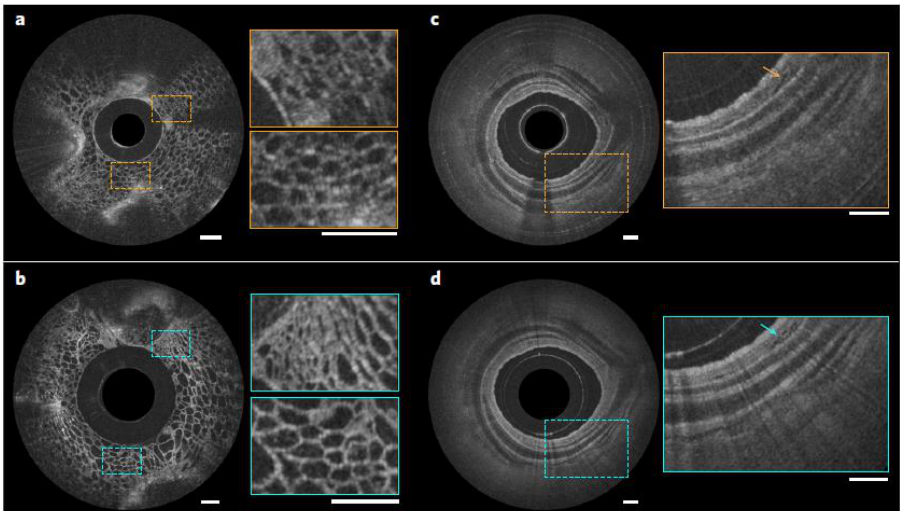
Figure 10. Comparison of the OCT images acquired using a nano-optic endoscope and a conventional OCT catheter. ( a , b ) OCT images of fruit flesh (grape) obtained using a ball lens catheter ( a ) and nano-optic endoscope ( b ). ( c , d ) Ex vivo images of a swine airway using a ball lens catheter ( c ) and nano-optic endoscope ( d ). The arrows indicate fine glands in the bronchial mucosa. All scale bars are 500 µ m. Reproduced with permission from [65]. Copyright © 2018, Springer Nature.